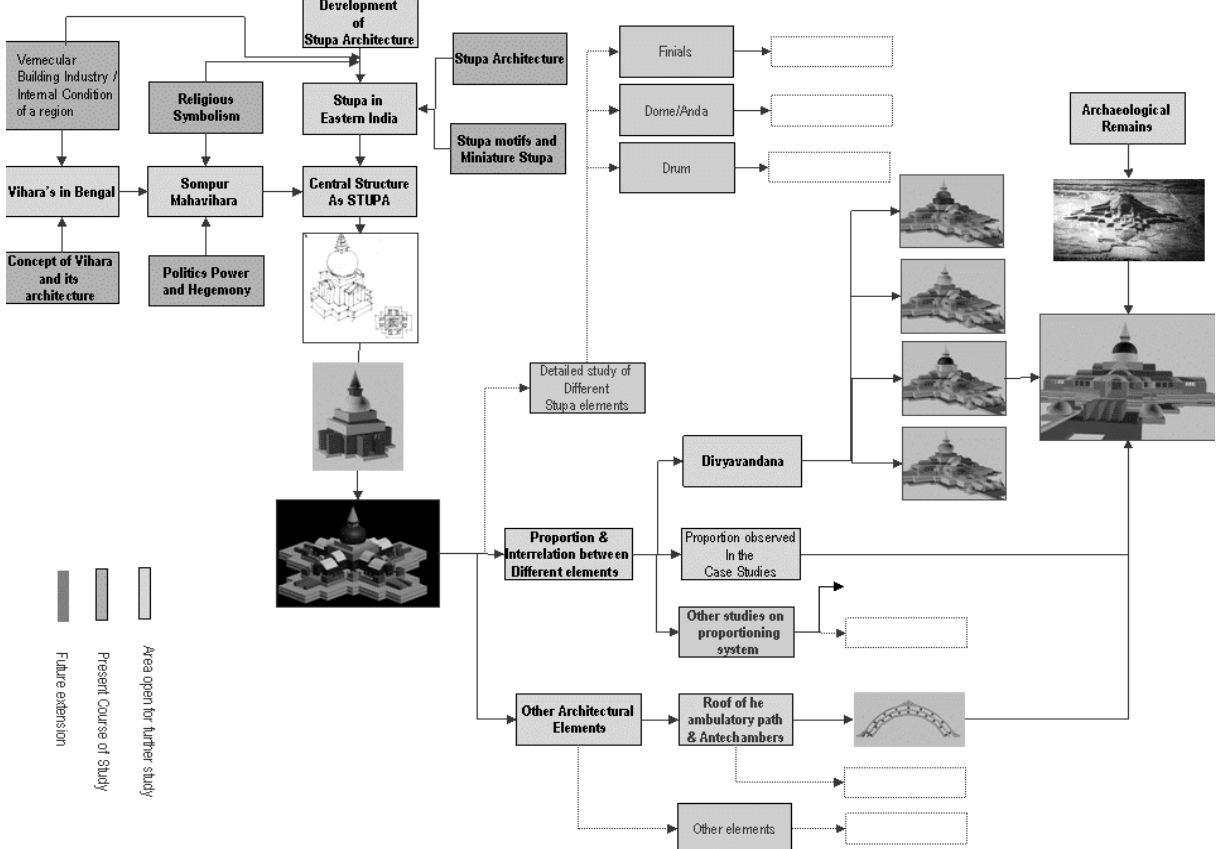
Fig. 3: Scheme showing the Virtual Knowledge Platform ( VKP) for Sompur Mahavihara (Rashid, 2006)